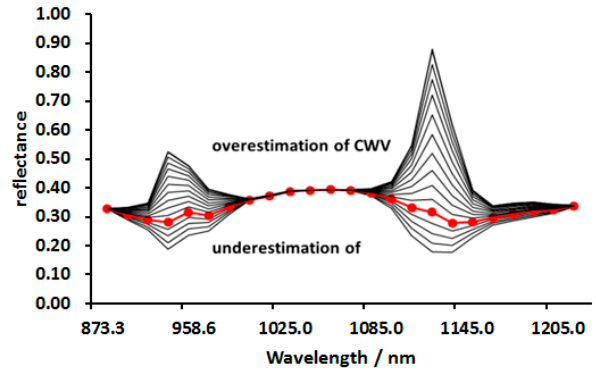
Figure 5. Second-order difference algorithm (SODA)-based reflectance spectra retrievals using different columnar water vapor values (CWVs) within the 890-nm and 1230-nm regions. The reflectance spectral labeled by closed circle “ ● ” is the smoothest spectral, upper which means the overestimated CWV, and lower which means the under estimated CWV.